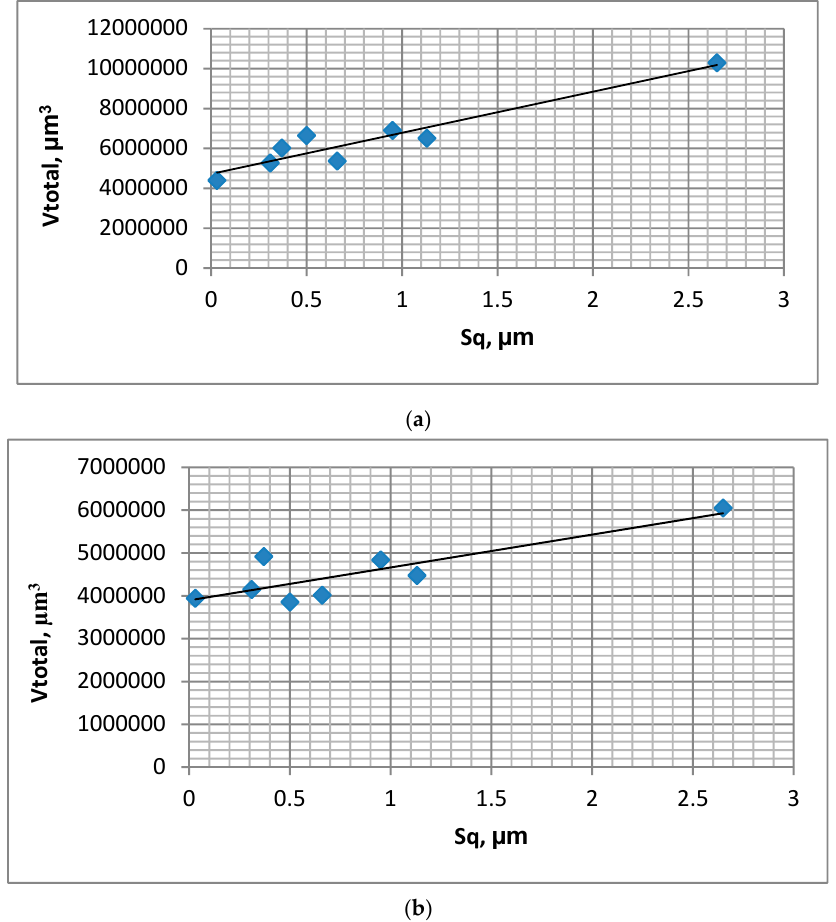
Figure 3. Dependence between disc surface height determined by the Sq parameter and total volumetric wear of tribological system V total during tests A; s = 0.2 mm, P = 45 N, f = 20 Hz ( a ) and B; s = 0.15 mm, P = 45 N, f = 20 Hz ( b ).